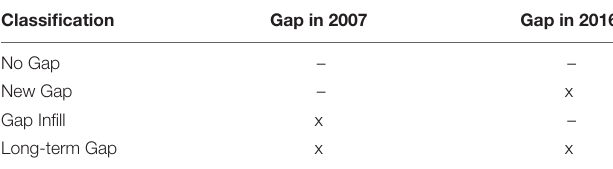
TABLE 2 | Gap classifications